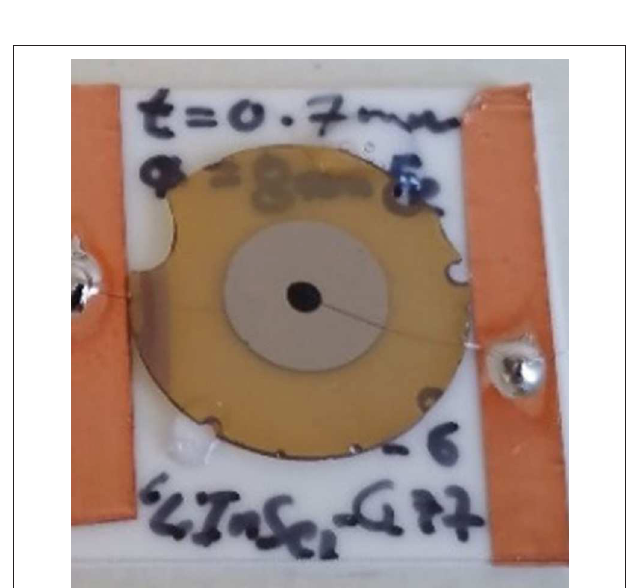
FIGURE 2 | The fabricated planar detector from ingot G77 (labeled as 6 LiInSe 2 -G77-6) with 0.7mm thickness and 8mm Fe contact diameter. The sample is wired using 2 mil Pd wire attached to Fe contacts on both side with carbon paste. The planar detector is mounted on a 1 square inch ceramic substrate using RTV Si based